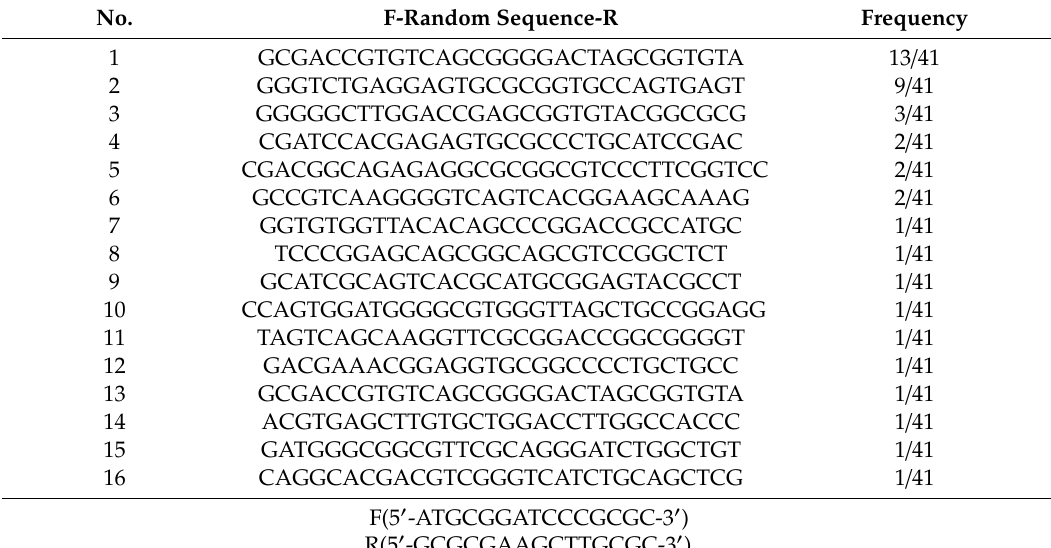
Table 1. Selected aptamer sequences after seven rounds of